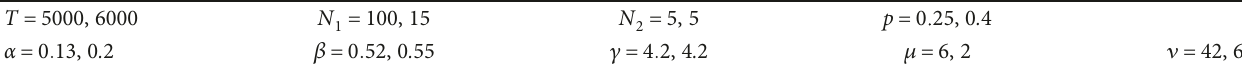
Table 2: The parameters of Synthetic-1 and Synthetic-2.